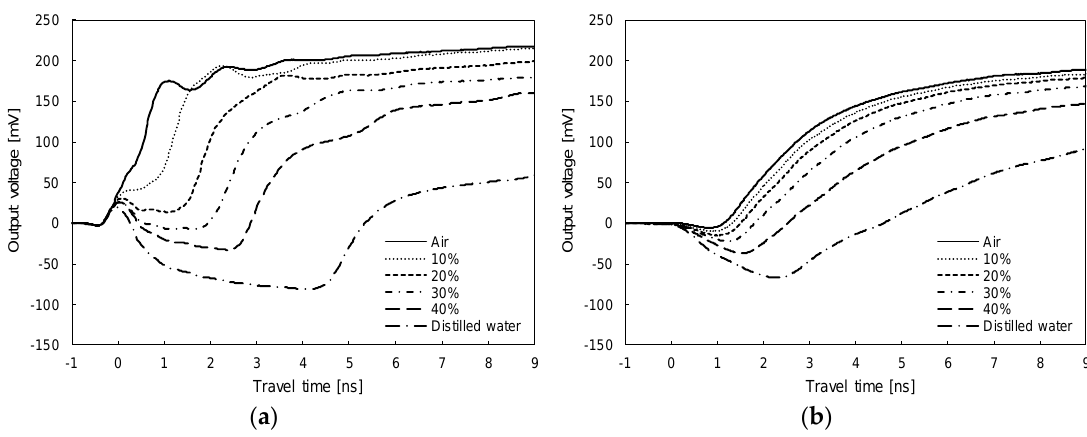
Figure 5. Signals at different testing samples measured using the: ( a ) TDR probe; ( b ) TDCP probe.